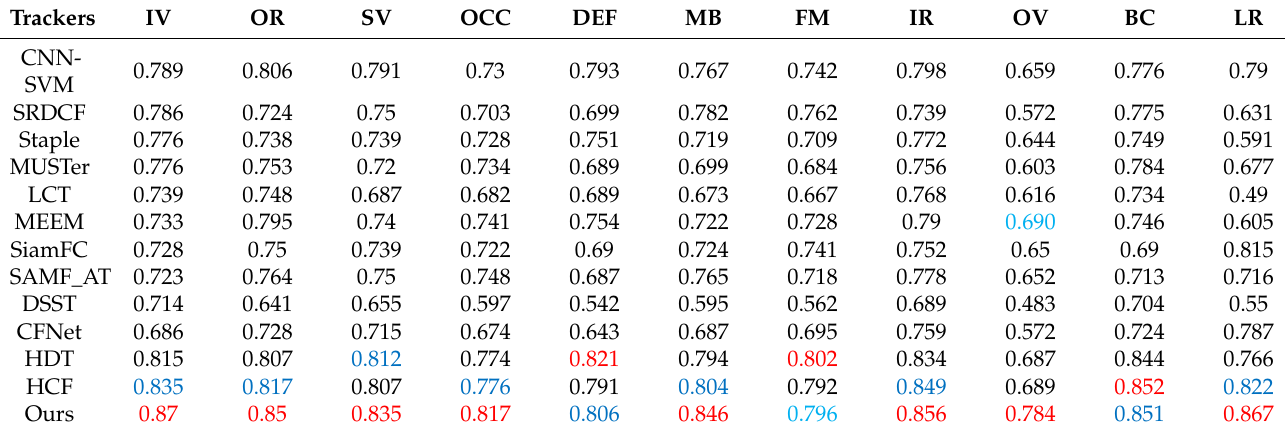
* For the scores in Table 3, 11 columns represent the performance of different algorithms under 11 challenge attributes, and 13 rows represent the performance of 13 algorithms under different challenge attributes. The best and the second-best precision in each column are highlighted in red and blue